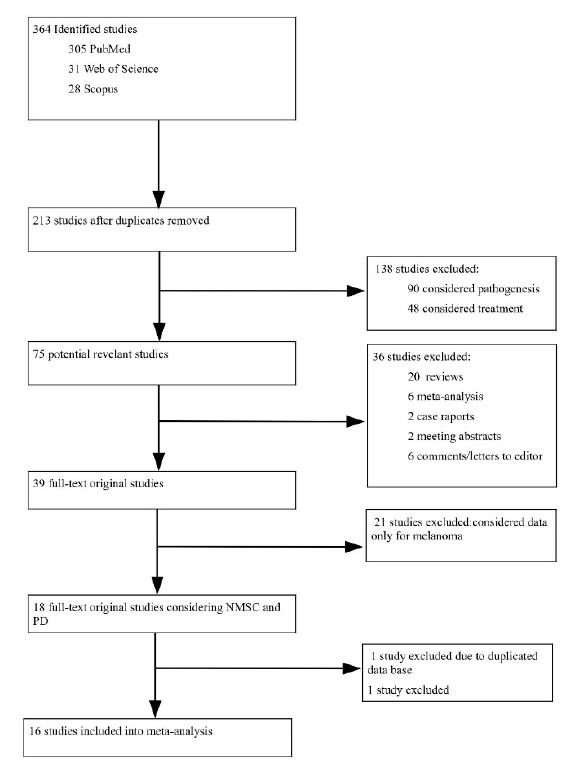
Figure 1. Flow diagram of a paper’s selection process.